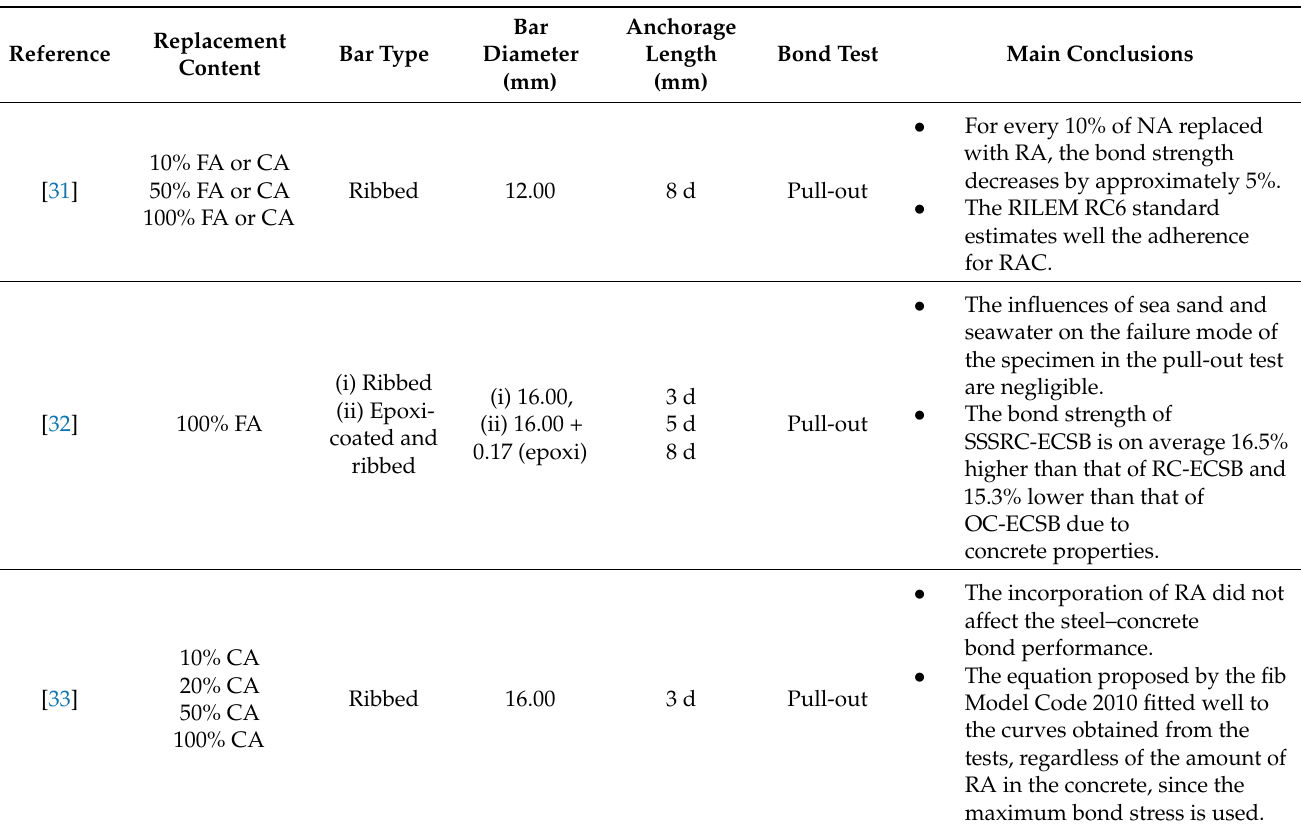
Table 4. Main details and conclusions from the selected